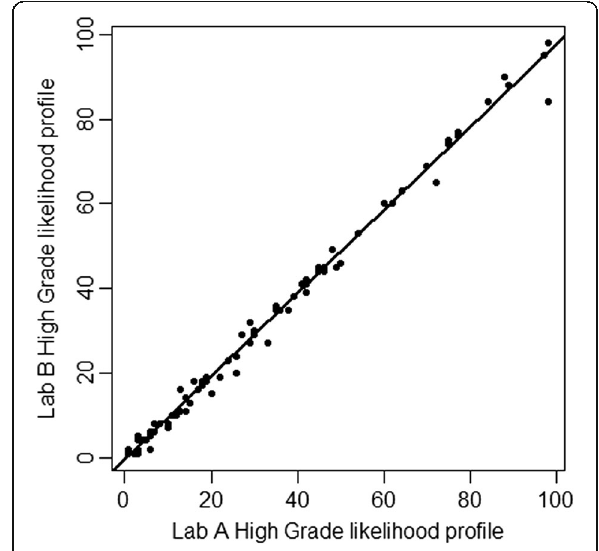
Fig. 4 Scatter plot showing the correlation between the likelihood profiles for high-grade PCa upon biopsy obtained for 99 urine samples analyzed at Lab. A and Lab. B with y =0.982, r =0.997 and P